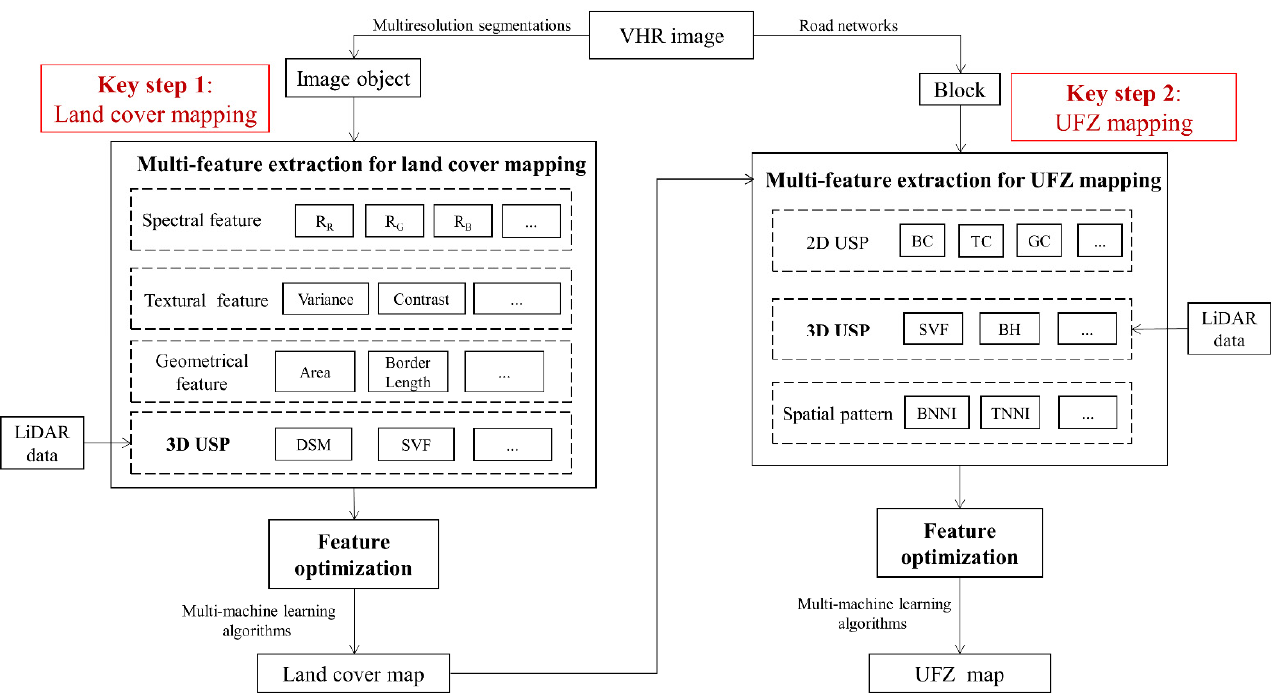
Figure 3. Workflow of the study.